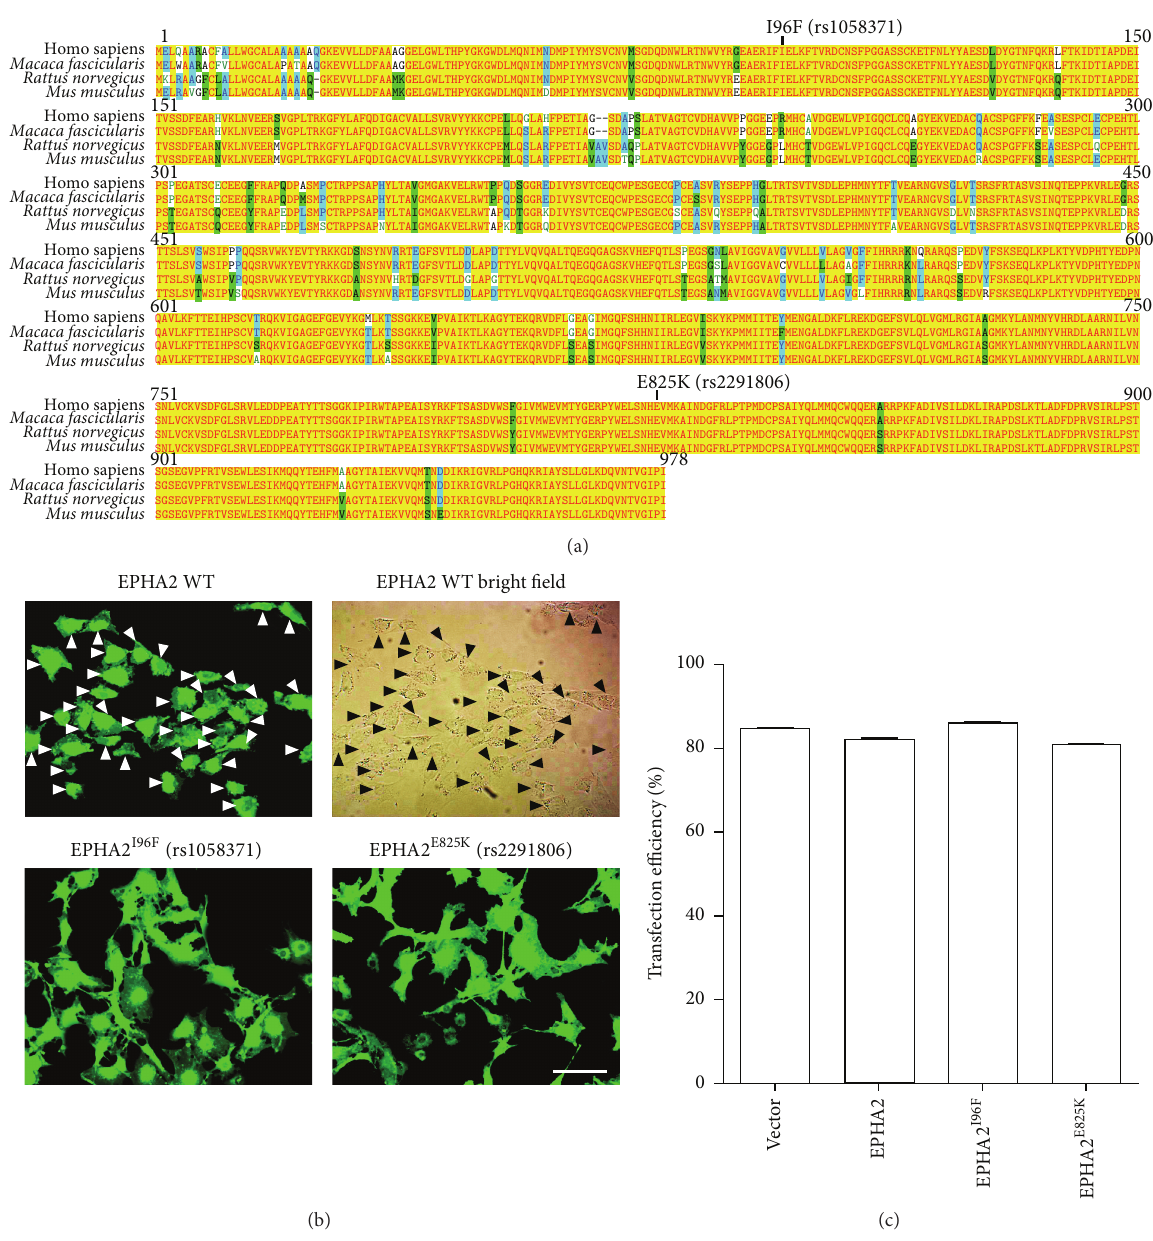
Figure 1: The evolutional conservation of cataract-associated SNP and the overexpression of EPHA2 in lens epithelial cells. (a) The protein sequences of human, macaque, rat, and mouse EPHA2 were aligned for multiple comparison. The functional polymorphisms rs1085371 and rs2291806 are highlighted here to show the missense mutation in EPHA2. The sequence alignment shows the evolutional conservation of both amino acids with substitution. (b) The human lens epithelial cells (HLECs) were infected with lentivirus encoding wild-type EPHA2, EPHA 2 I 96 F , or EPHA 2 E 825 K . The images captured with fluorescent microscopy 72 h after infection are shown here. Scale bar: 50 𝜇 m. (c) The infection efficiency was quantified by counting GFP-positive cells and total number of cells. Data are shown as the mean ± SEM.